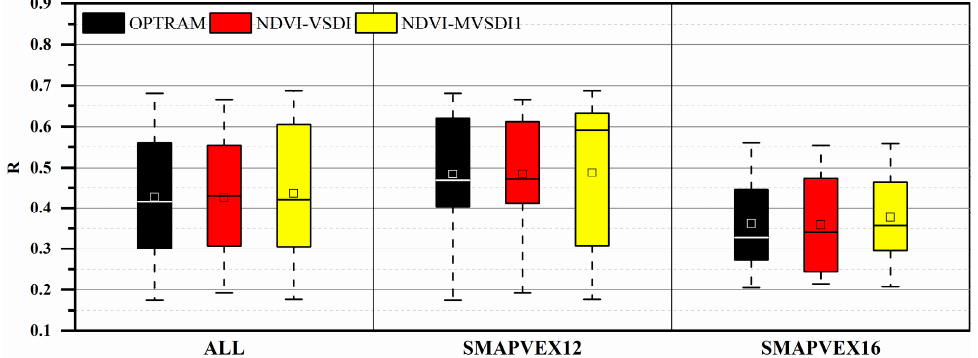
Figure 12. Comparisons between OPTRAM, modifications of OPTRAM (i.e., NDVI-VSDI and NDVI-MVSDI1), and aircraft SM.